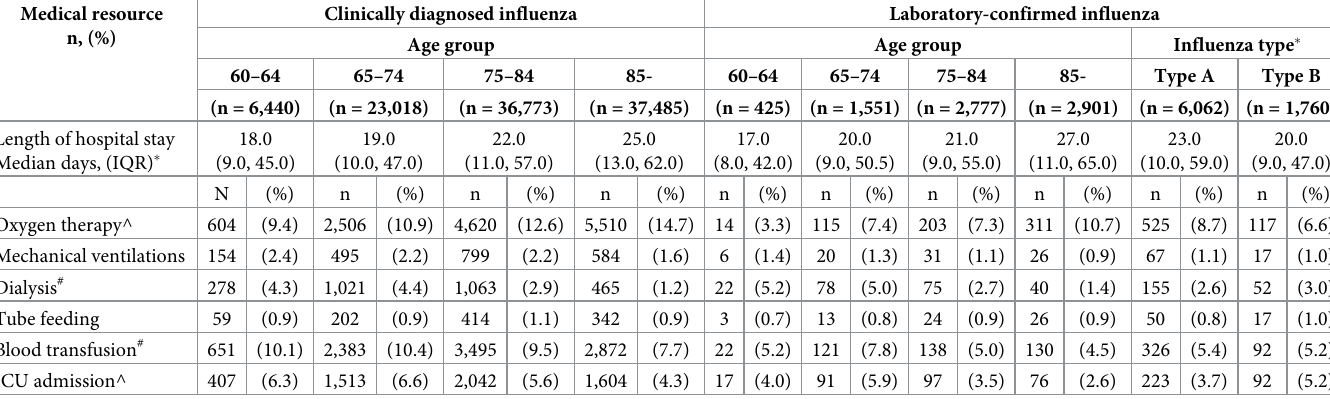
Table 5. Medical resource consumption in inpatients with clinically diagnosed and laboratory confirmed influenza. Medical resource n, (%)